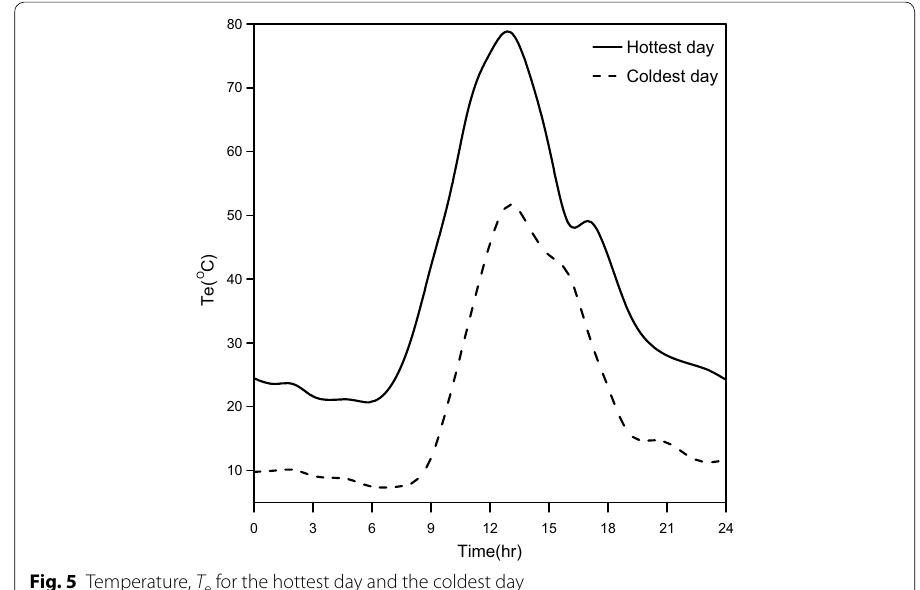
Fig. 5 Temperature, T e for the hottest day and the coldest day